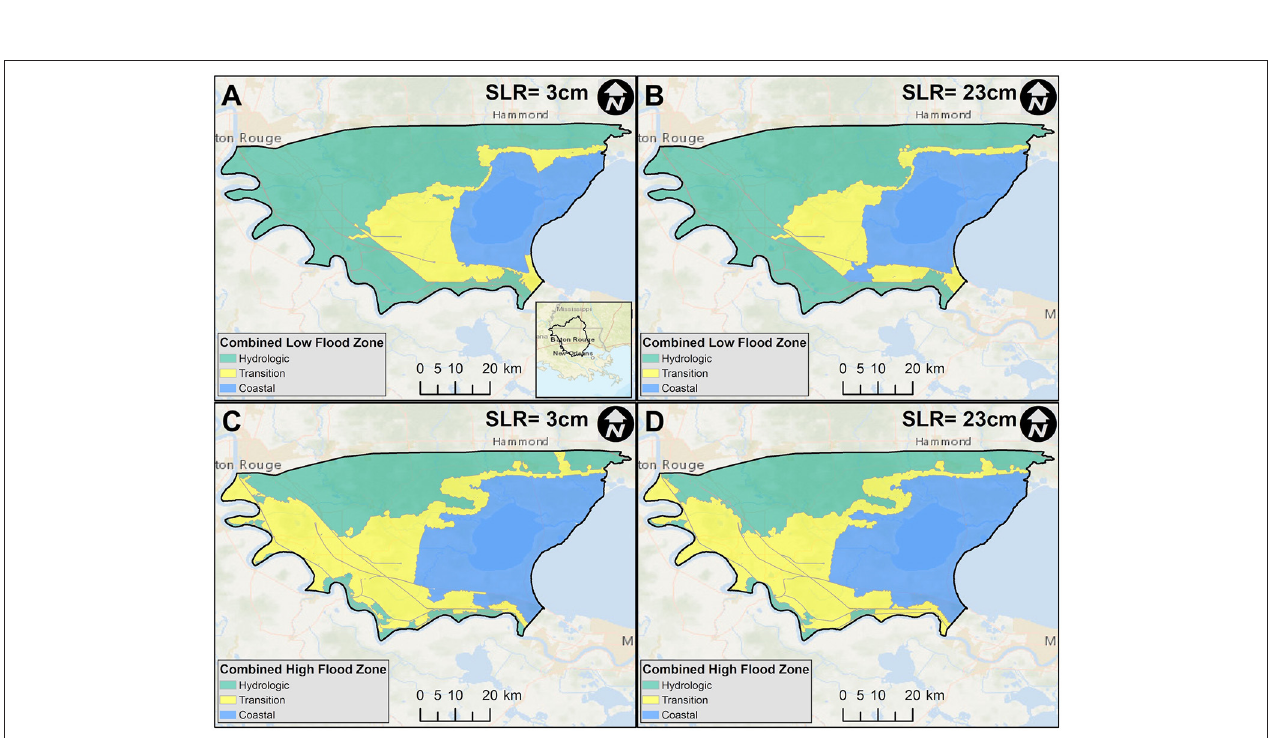
FIGURE 13 | Compound flood hazard zones delineation for the Lake Maurepas watershed using (A,B) low and (C,D) high flood events for the 2010 condition with different water levels at the Gulf of Mexico: (A,C) 3cm and (B,D) 23cm.